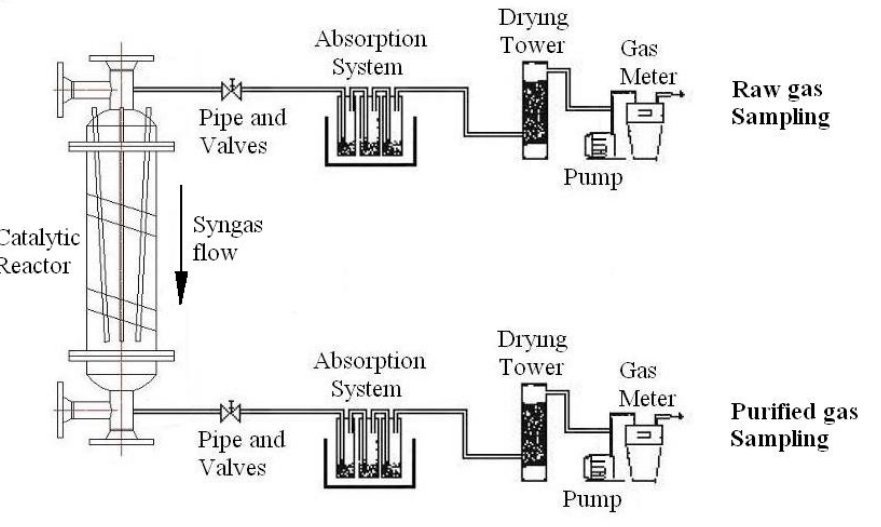
Figure 4. Sampling processes of syngas before and after